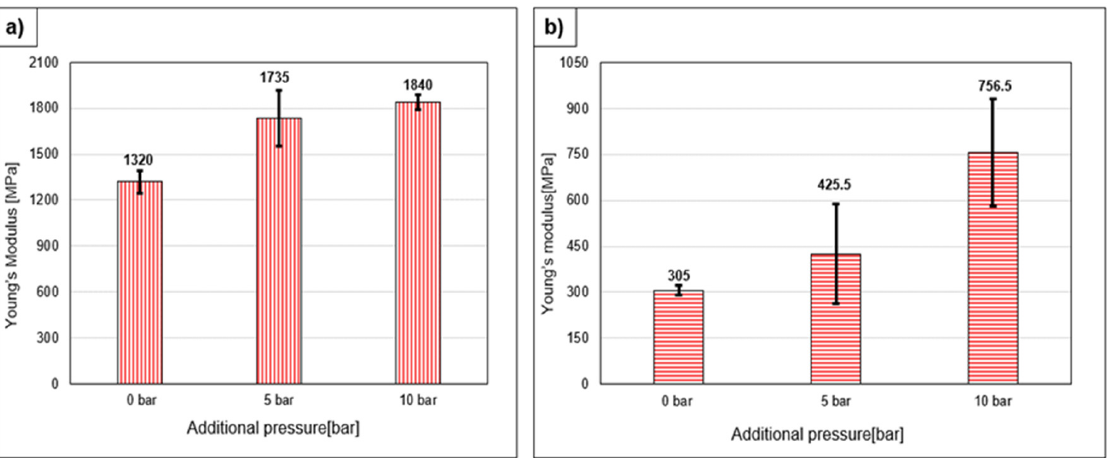
Figure 4. Young’s modulus comparison of samples printed in different pressure conditions ( a ) longitudinal and transverse ( b ) to the printing direction.